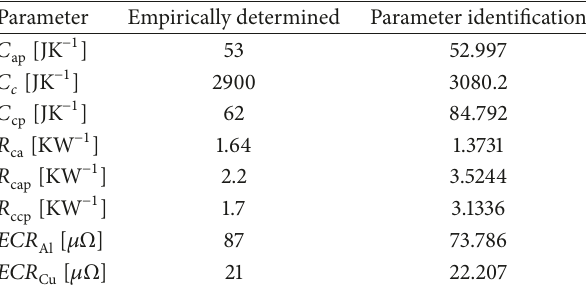
Table 1: Obtained parameter